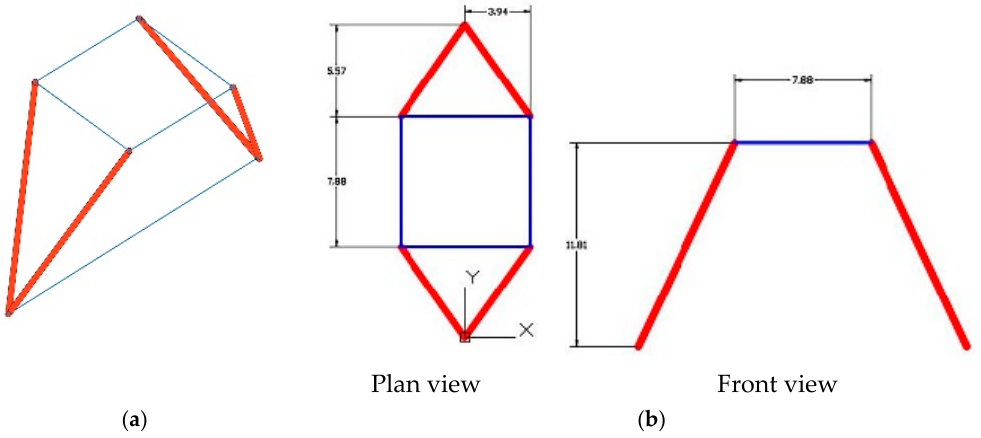
Figure 3. ( a ) Three-dimensional geometric diagram of the connecting rods and crosspieces; ( b ) geometric diagram of the system of connecting rods and crosspieces working